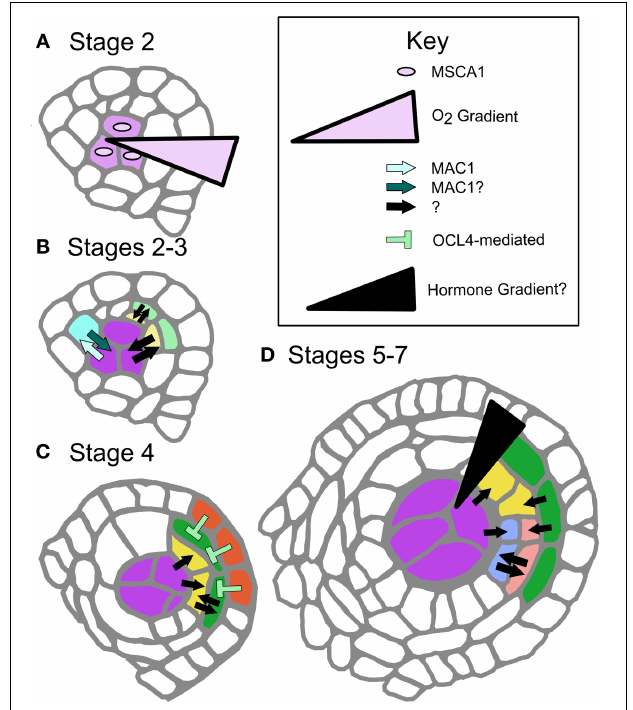
FIGURE 2 | Defined and proposed signaling networks in pre-meiotic maize development. (A) Specification of AR cells is dependent on oxygen status interaction with MSCA1; hypoxic conditions stimulate AR cell differentiation. (B) As AR cells differentiate, they secrete the ligand MAC1, which is putatively perceived by LRR-RLK-type receptors on the L2-d cells, specifying these cells as soma and likely stimulating them to become PPC. MAC1 is also inferred to negatively regulate proliferation of AR cells until an entire column is formed in W23 (Wang et al., 2012). At these and later stages there are likely other cell-to-cell communication networks, indicated as black arrows with questions marks. These signals may be other ligand-receptor pairs, siRNAs, or other as yet undiscovered factors. (C) The differentiated EPI expresses transcription factor OCL4, which indirectly represses periclinal division in the neighboring EN, possibly by assisting with EN differentiation (Vernoud et al., 2009). (D) The trigger for periclinal division of the SPL, differentiation of the ML and TAP cell fates and maintenance of these fates is completely unexplored. A variety of cell-to-cell communication pathways might be in use (black arrows), or there may be a locally produced hormone gradient(s) along the